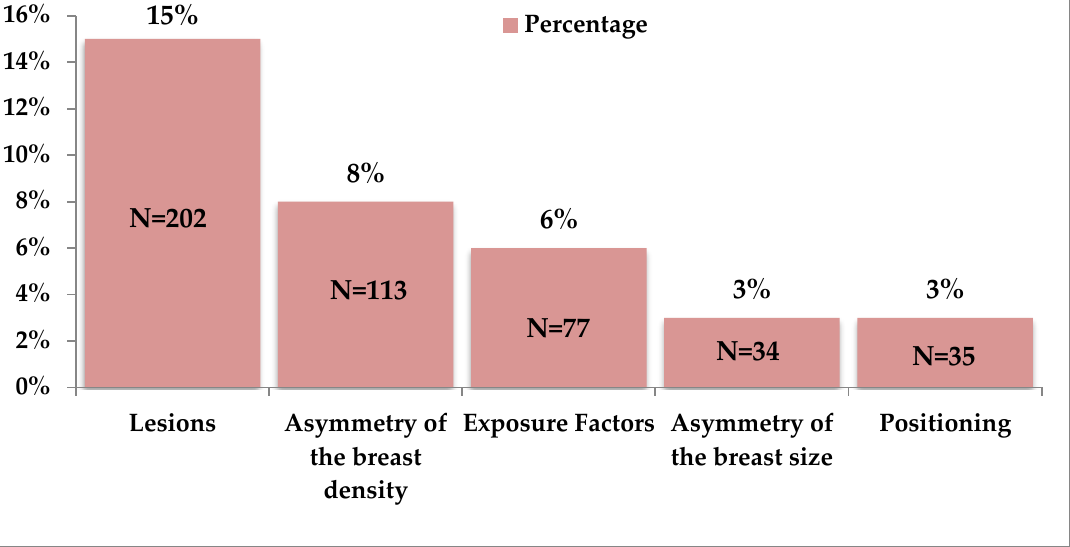
Figure 4. Percentage of the distractors within total cases according to the number of reads, as decided by the UK radiologists.